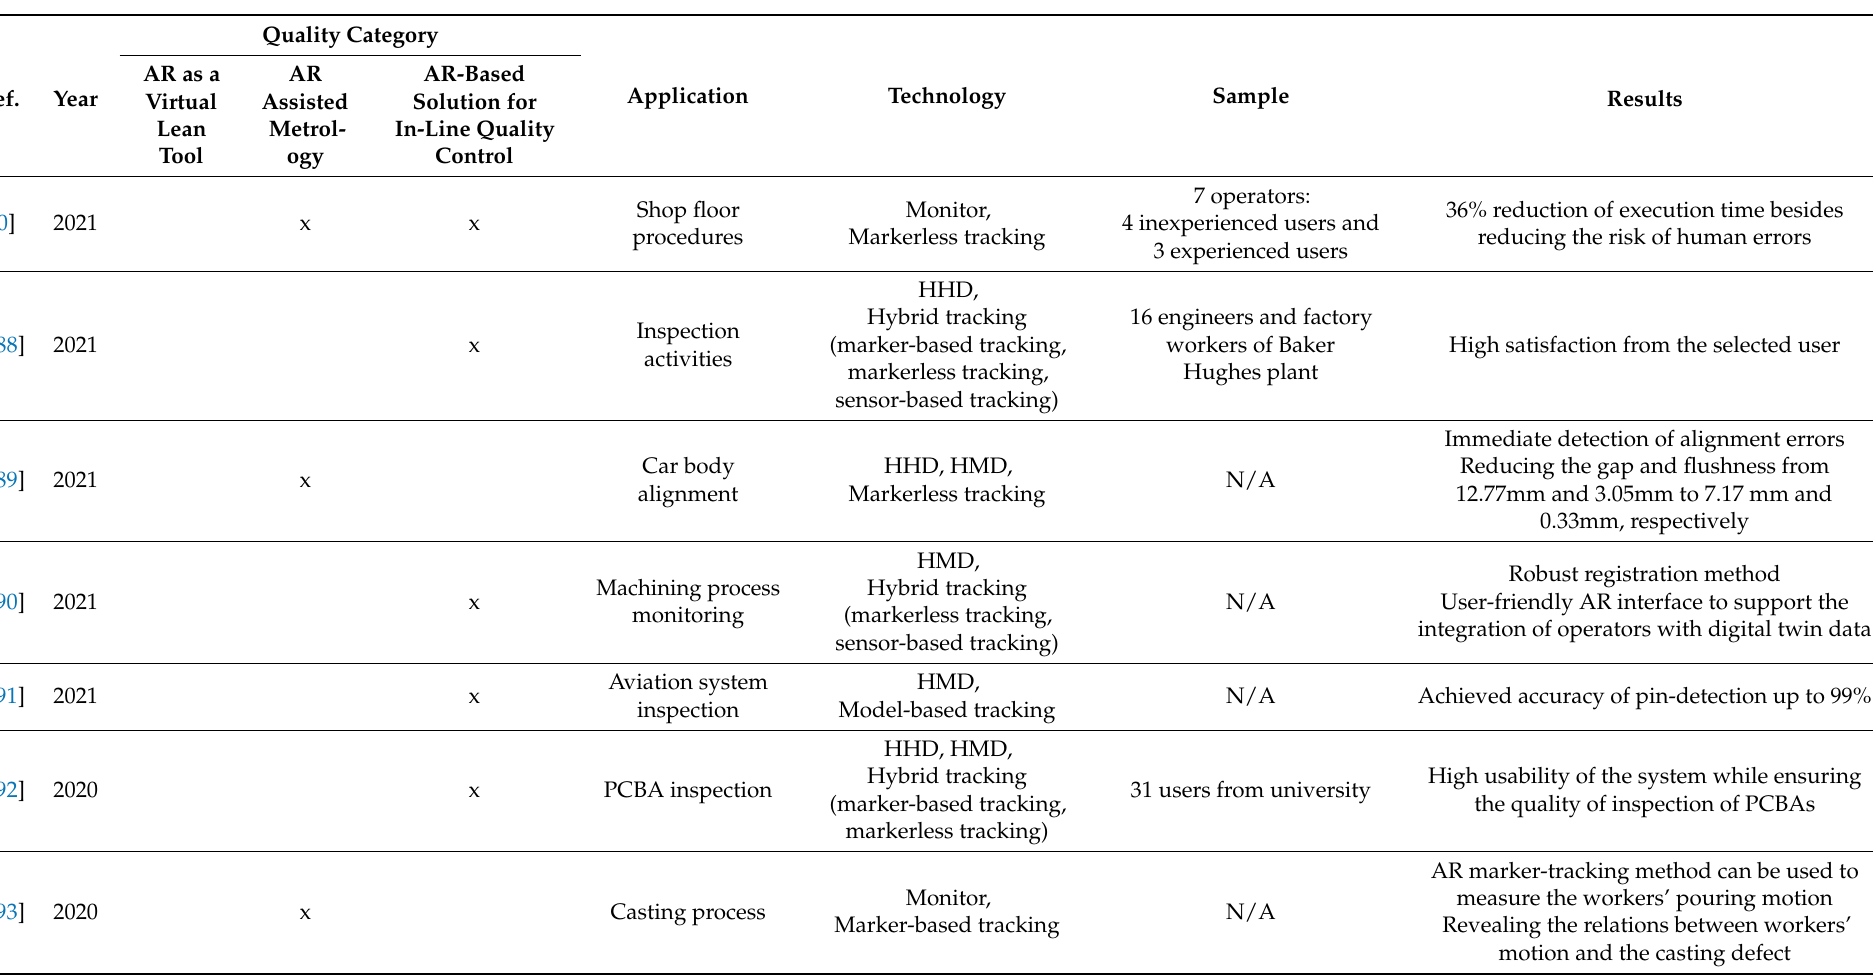
Table 7. Categories of current AR-assisted